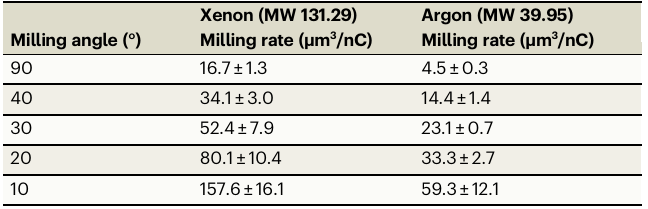
Table 2 | Measured milling rates taken from triplicate mea- surements on plunge-frozen HeLa samples with varying milling